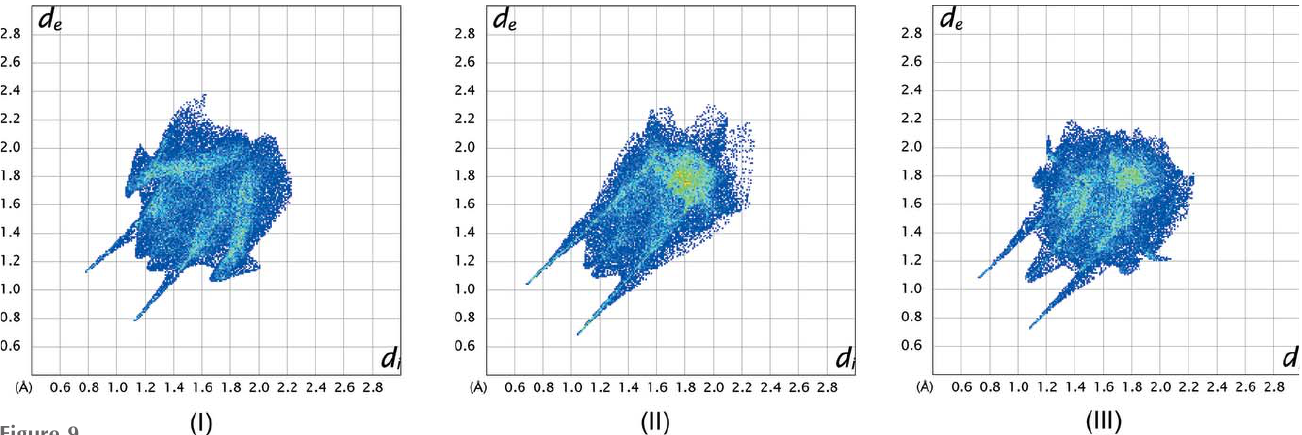
Figure 9 The FP plots for 1 , 2 and 3 . The pair of southwest spikes are due to the O (cid:3)(cid:3)(cid:3) H /H (cid:3)(cid:3)(cid:3) O close contacts. The highest intensity of pixels in the FP plot for 2 at d e / d i = 1.8 A˚ includes C (cid:3)(cid:3)(cid:3) C contacts.